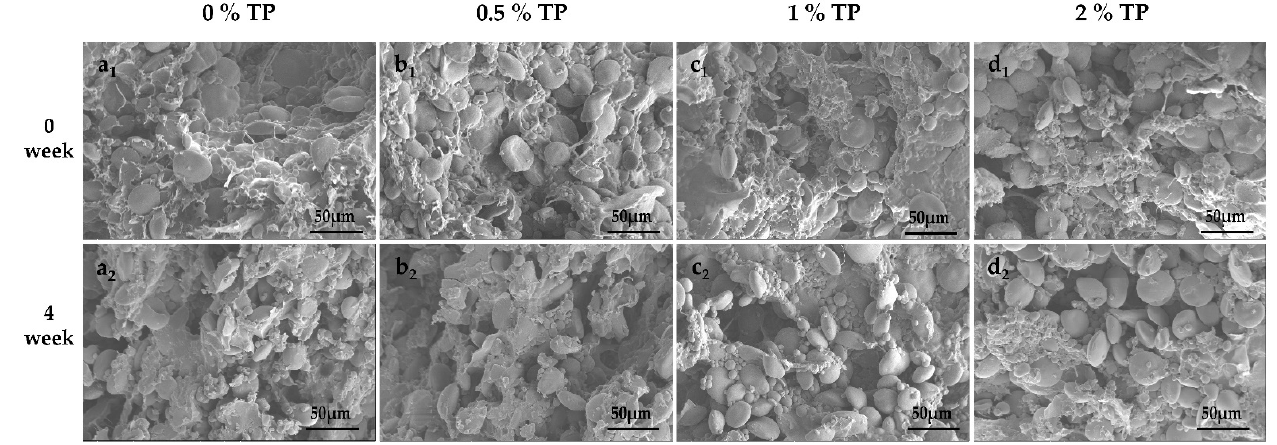
Figure 8. Microstructures of NFFD with TPs at different storage periods ( a–d represent 0% TP, 0.5% TP, 1% TP, and 2% TP, respectively). TP, 1% TP, and 2% TP,